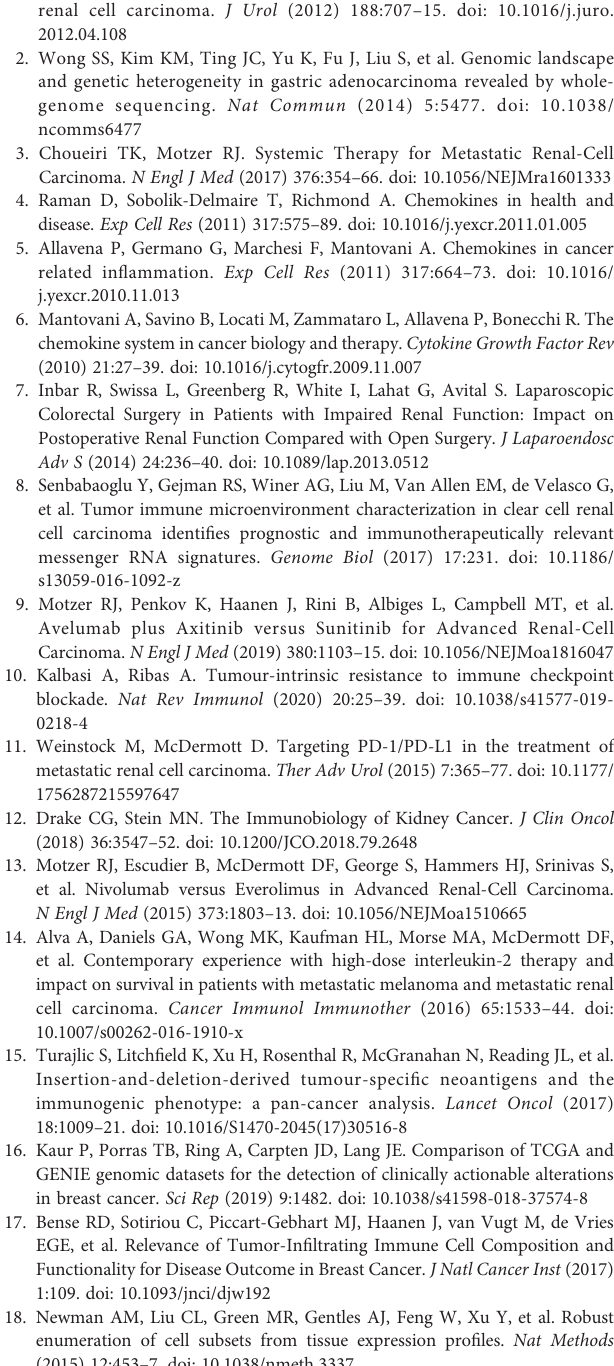
Supplementary Figure 7 | Validation clinical characteristics of the TIICs in GSE68748. Supplementary Figure 8 | Validation clinical characteristics of the TIICs in GSE73731.